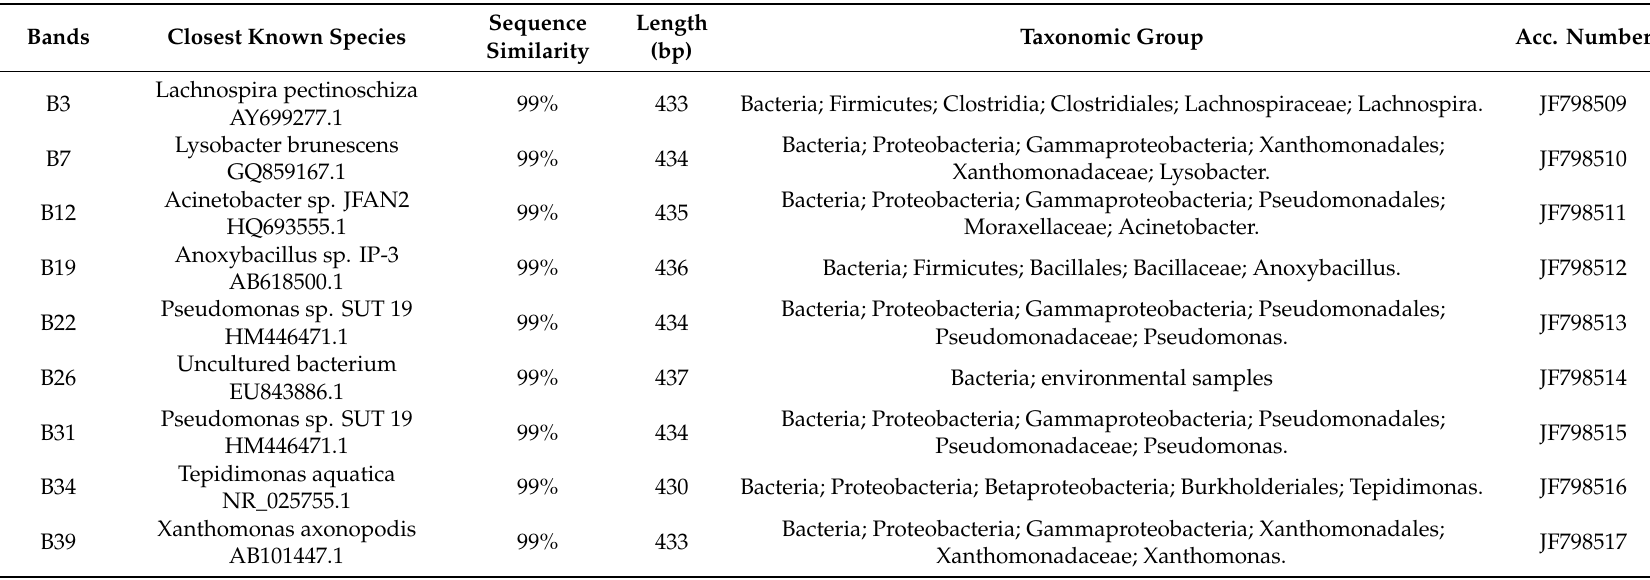
Table 5. Detailed information of rumen bacterial 16S rDNA